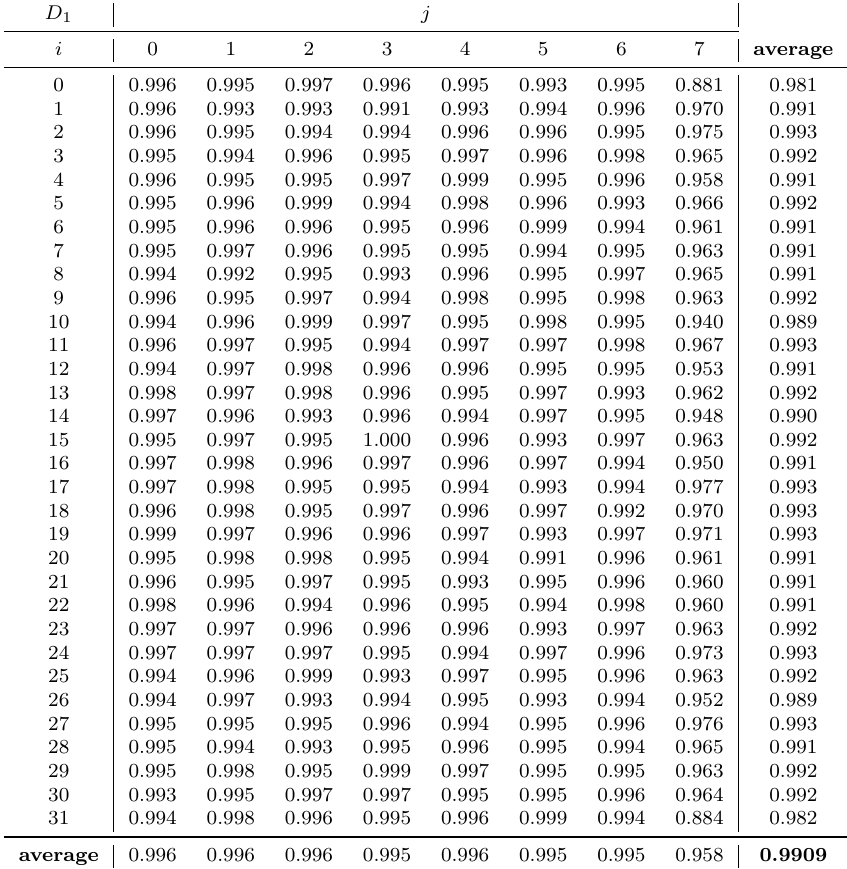
Table 12: Empirical probability to recover the message bit m [8 i + j ] from a single trace using POL2MSG() . Average results for 1K traces from device D 1 (profiling). D 1